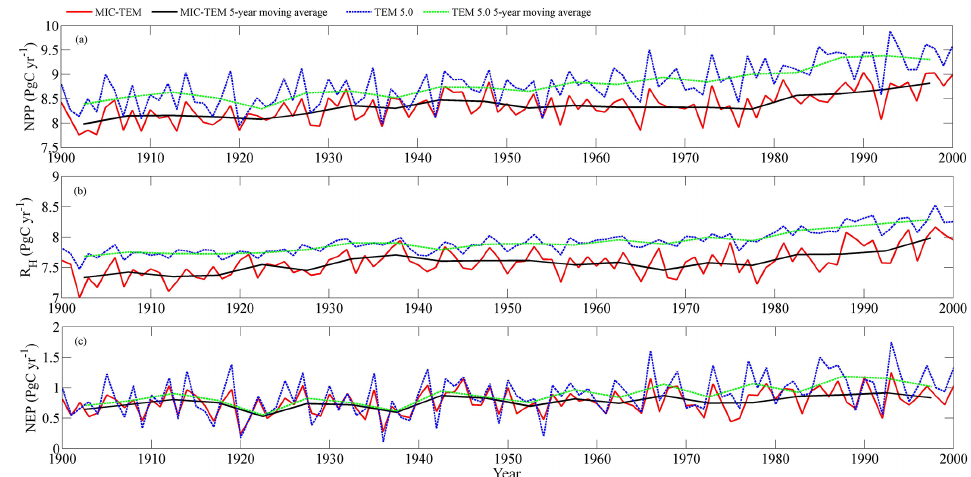
Figure 2. Simulated annual net primary production (NPP, a ), heterotrophic respiration ( R H , b ), and net ecosystem production (NEP, c ) by MIC-TEM and